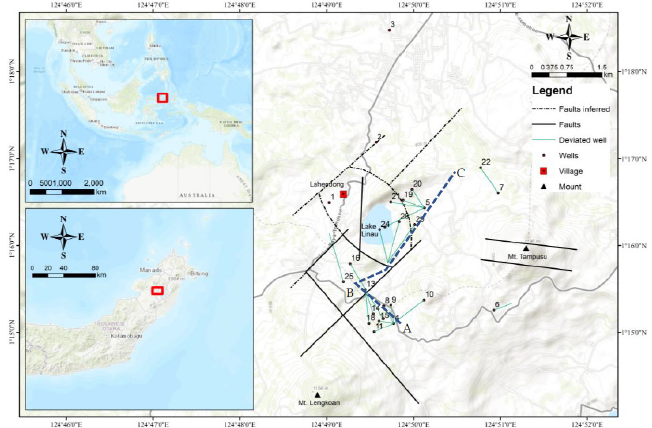
Figure 1. Location of Lahendong geothermal field (Detailed faults and wells are based on Brehme et Figure1. LocationofLahendonggeothermalfield(DetailedfaultsandwellsarebasedonBrehmeetal.[5] al. [5] and Koestono [7]). and Koestono